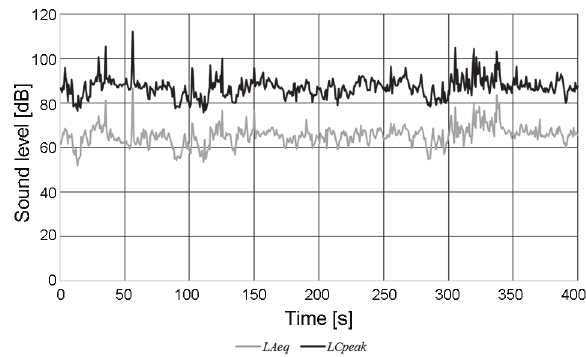
Figure 2. C-Weighted peak sound level L Cpeak (upper course) and A-Weighted equivalent sound level L Aeq (lower course) registered at one measuring